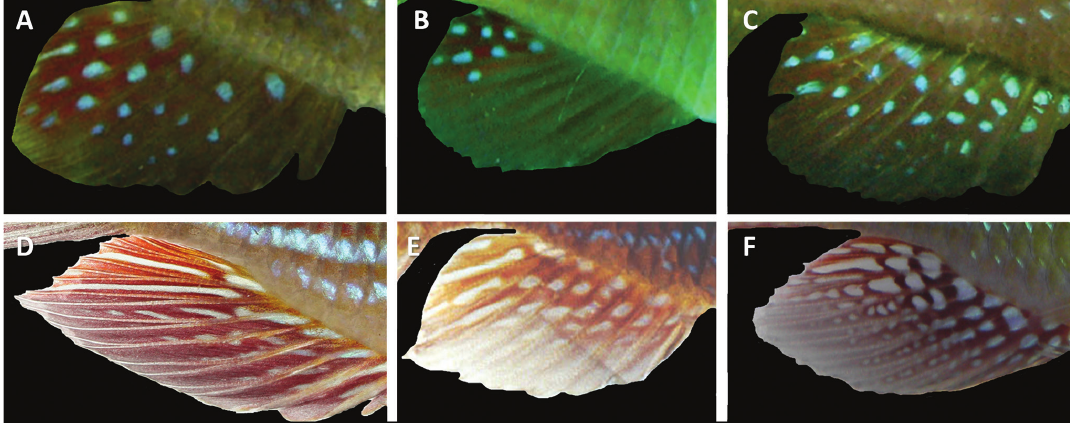
Fig. 4 .Anal fin pigmentation patterns: (A-C) Gymnogeophagus terrapurpura , (D-E) G. rhabdotus , (F) G. meridionalis